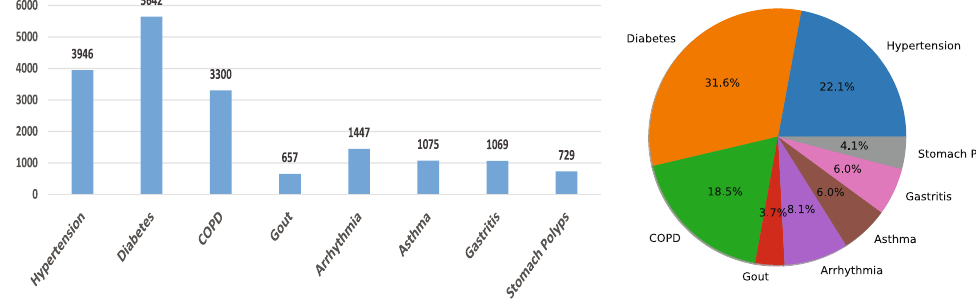
Figure 2. The number and proportion of each disease in C-EMRs.